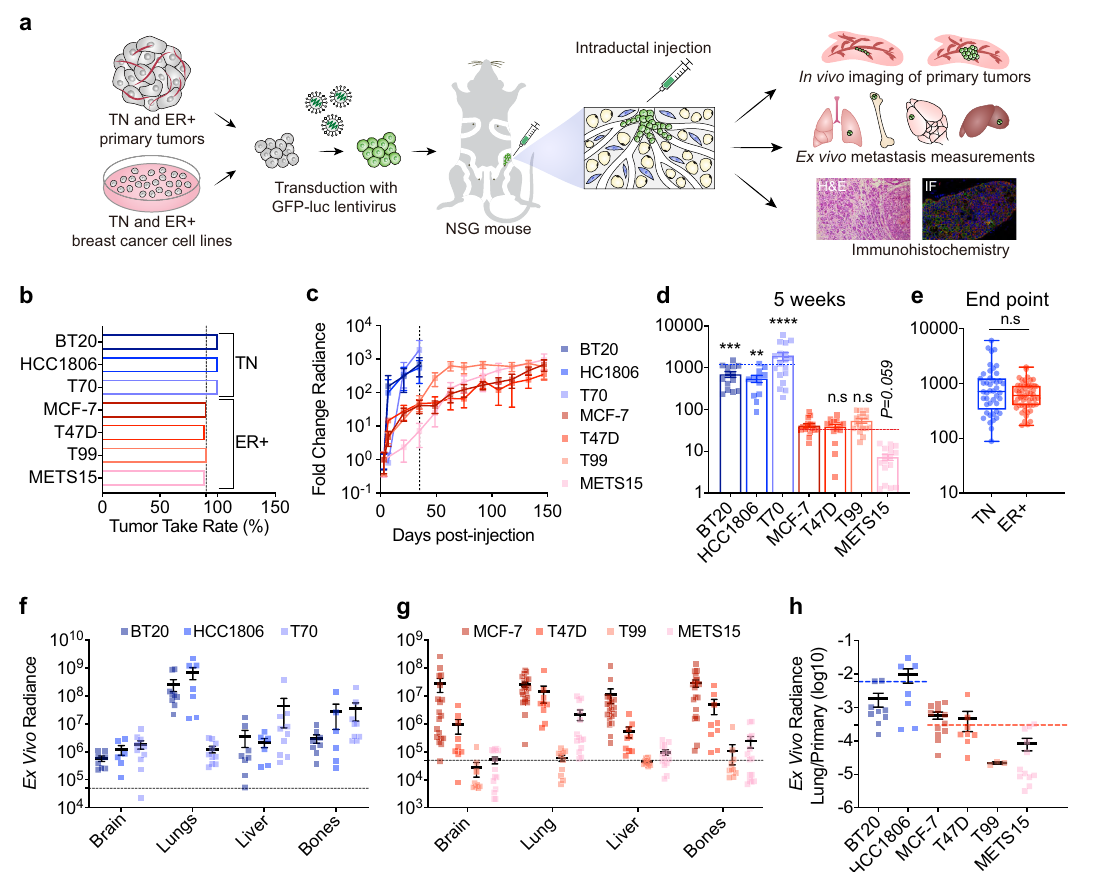
Fig. 1 | ER + and TN BC cells show distinct growth and metastatic behavior. a Scheme illustrating the intraductal xenografting approach used in this study. Η &E: Haematoxylin & Eosin, IF: Immuno fl uorescence. b Bar graph showing take rates for TN (blue) and ER + (red) BC cells injected intraductally, 13 – 19 mammary glands of 5 – 9 mice injected in each group. The vertical dashed line indicates 90%. c Graph showing the fold-change of bioluminescence over time for all intraductal xenografts.Datarepresentmean±SEMof13-19mammaryglandsfrom5 – 9micein each group. The dashed line indicates the experimental end-point for TNBC xenografts. d Fold-change of bioluminescence at 5 weeks after intraductal injec- tion. Data represent mean±SEM of 13 – 19 mammary glands from 5 to 9 mice in each group. Blue and red dashed lines represent the average change biolumines- cence of TN (1148 fold) and ER + BC (32 fold), respectively. One-way ANOVA,